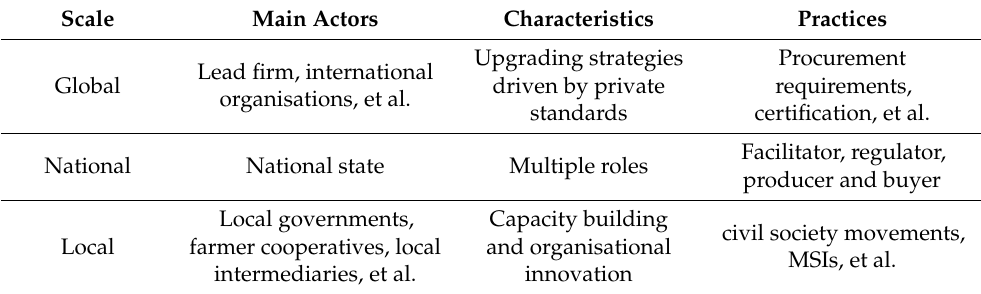
Table 1. Agricultural upgrading process from a global–local